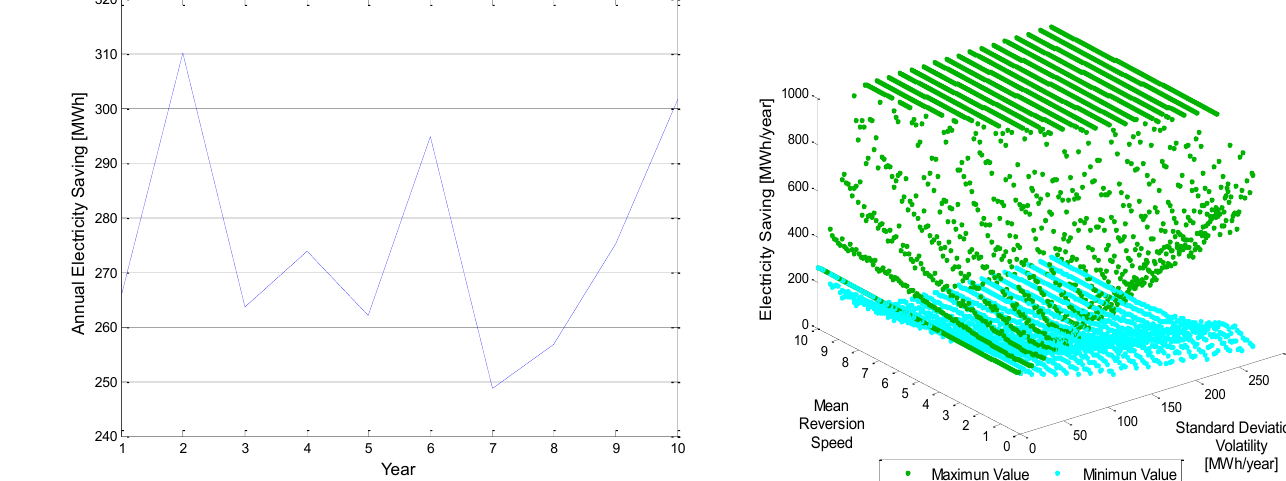
Fig. 3. Behavior of the annual electricity saving over time – one scenario